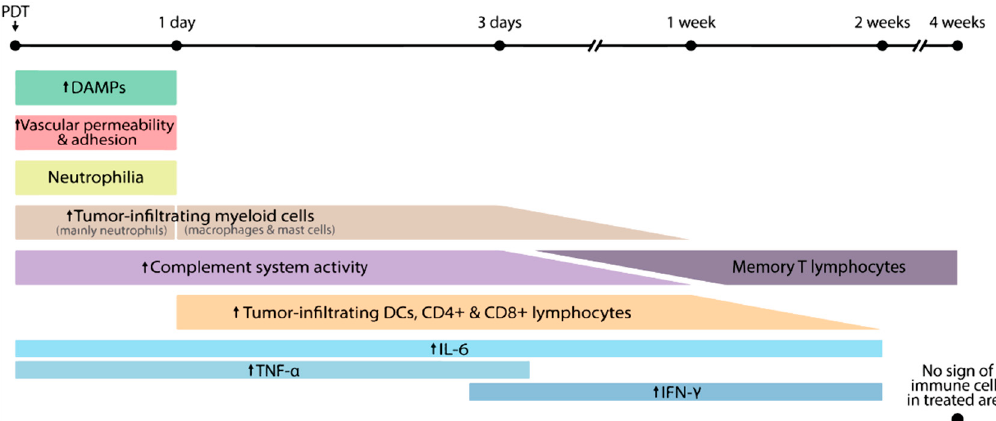
Figure 2. Indicative timeline of the main immunological events developed after PDT. Shortly after PDT, an initial inflammatory response arises due to the exposure of DAMPs and complement activation, and is facilitated by the increased vascular adhesion and permeabilization at the tumor site during the first 24 h post-PDT. A pronounced neutrophilia occurs, which is followed by increased numbers of tumor-infiltrating neutrophils during the first 24 h, and infiltrating macrophages and mast cells at least during the first 72 h. One day post-PDT, DCs and lymphocytes start accumulating at the tumor site. This triggered adaptive response might last for two weeks and is accompanied by high levels of IL-6, TNF- α , and IFN- γ , as well as elevated complement activity. The initial immunological response is transient and four weeks post-PDT immune cells are no longer detected in the treated area. After this initial response, tumor-specific memory effector T cells can be expected to be present in circulation or in the tumor-draining lymphoid organs.